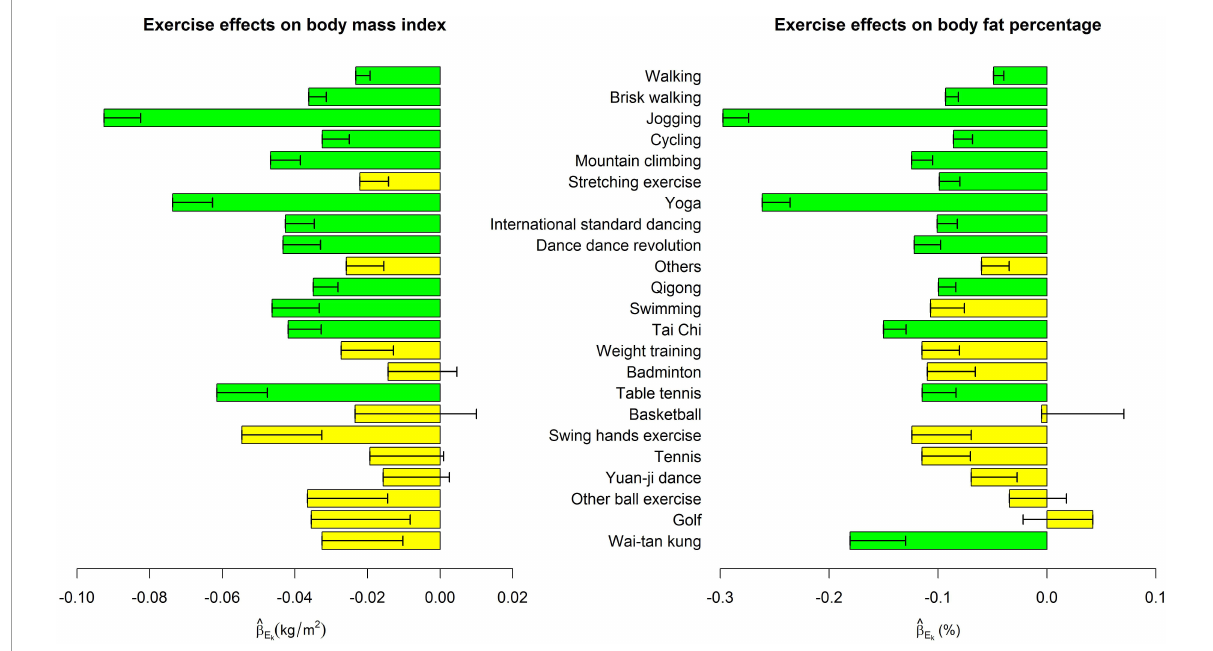
FIGURE1 Exercise main effects on body mass index and body fat percentage. The bars represent ˆ β E standard error of ˆ β E , where k = 1, ... , 23. Bars with p < 0.0004 = 0.05/(23 × 5) were highlighted in green color. k